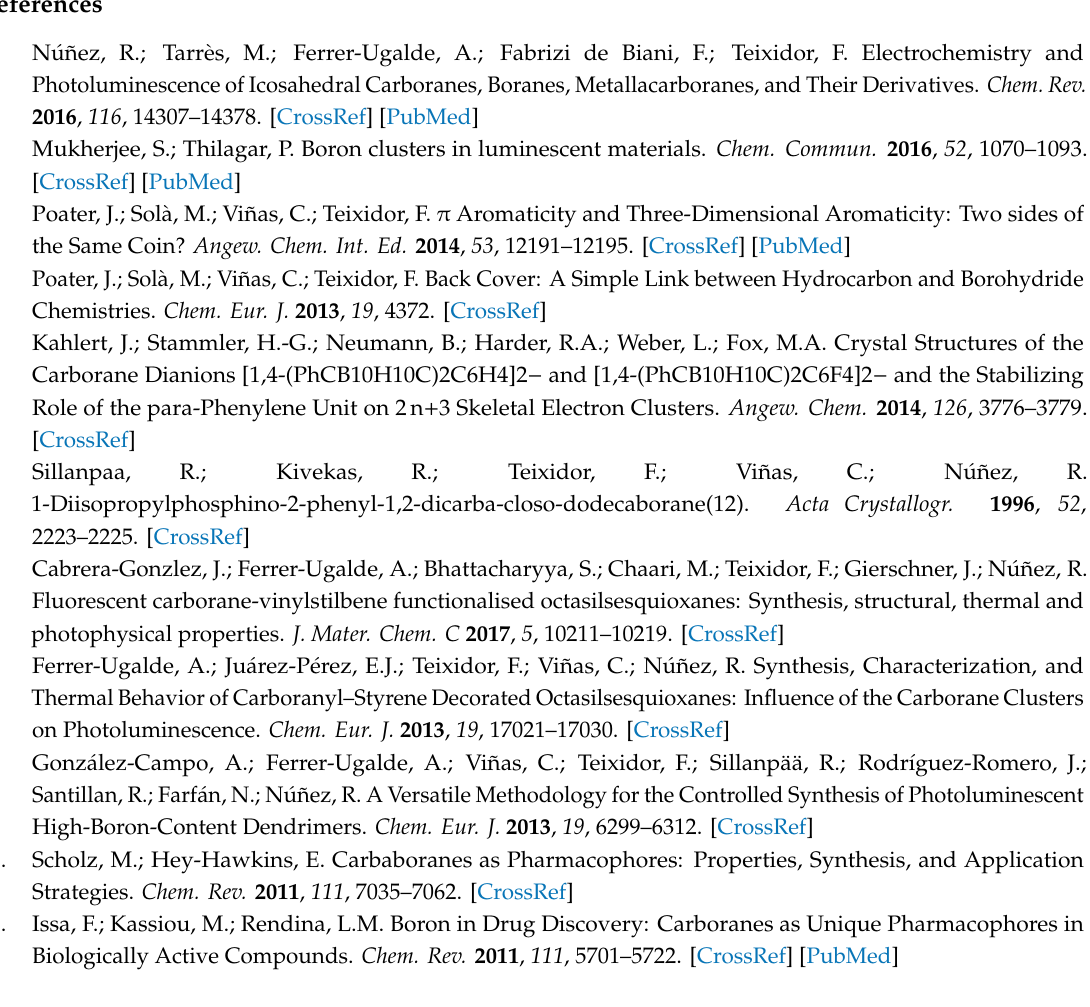
Figure S2: 1 H NMR (acetone-d 6 , 300 MHz) of 4 ; Figure S3: 11 B{ 1 H} NMR (acetone-d 6 , 300 MHz) of 4 ; Figure S4: 13 C{ 1 H} NMR (acetone-d 1 H NMR (acetone-d 11 B{ 1 H} NMR 6 , 300 MHz) of 4 ; Figure S5: 6 , 300 MHz) of 5 ; Figure S6: (acetone-d 6 , 300 MHz) of 5 ; Figure S7: 13 C{ 1 H} MR (acetone-d 6 , 300 MHz) of 5 ; Figure S8: 1 H NMR (acetone-d 6 , 300 MHz) of 6 ; Figure S9: 11 B{ 1 H} NMR (acetone-d 6 , 300 MHz) of 6 ; Figure S10: 13 C{ 1 H} NMR (acetone-d 6 , 300 MHz) of 6 ; Figure S11: 1 H NMR (acetone-d 6 , 300 MHz) of T8-B12 ; Figure S12: 11 B{ 1 H} NMR (acetone-d 6 , 300 MHz) of T8-B12 ; Figure S13: 13 C{ 1 H} NMR (acetone-d 6 , 300 MHz) of T8-B12 ; Figure S14: FTIR-ATR spectrum of 4 ; Figure S15: FTIR-ATR spectrum of 5 ; Figure S16: FTIR-ATR spectrum of 6 ; Figure S17: FTIR-ATR spectrum of T 8 -B 12